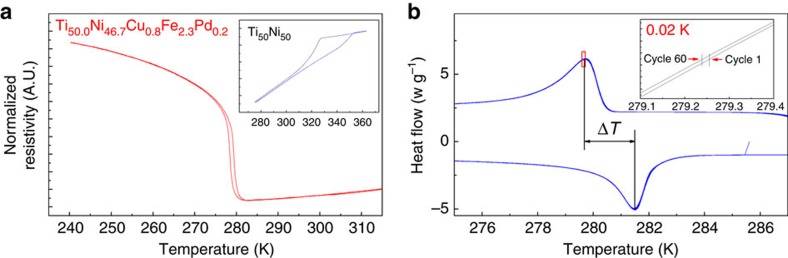
Experimental measurements for the predicted Ti50.0Ni46.7Cu0.8Fe2.3Pd0.2 alloy.(a) Resistivity measurements for the new alloy, Ti50.0Ni46.7Cu0.8Fe2.3Pd0.2 , compared with NiTi (inset) emphasize the very small hysteresis (0.84 K). (b) DSC curves for Ti50.0Ni46.7Cu0.8Fe2.3Pd0.2 , whose peak-to-peak ΔT is measured as 1.84 K, which is the lowest among related NiTi-based SMAs. Thermal cycles (60 heating and cooling cycles) also show very small shift (∼0.02 K in the inset), indicating excellent thermal fatigue resistance.